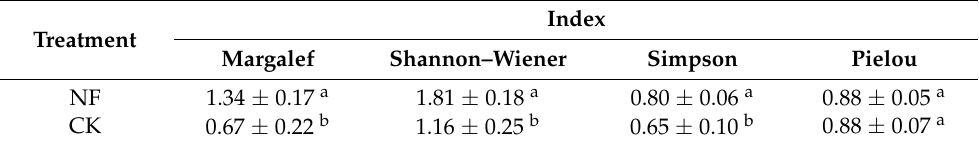
Table 1. Changes in plant diversity under main land-use types (mean ±